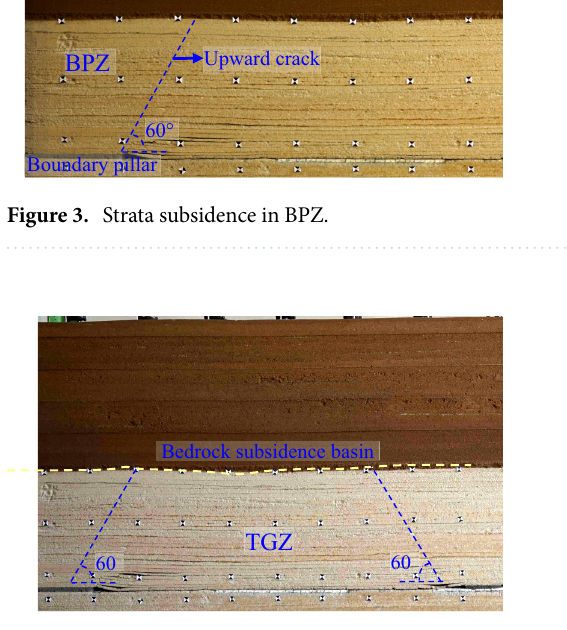
Figure 4. Strata subsidence in